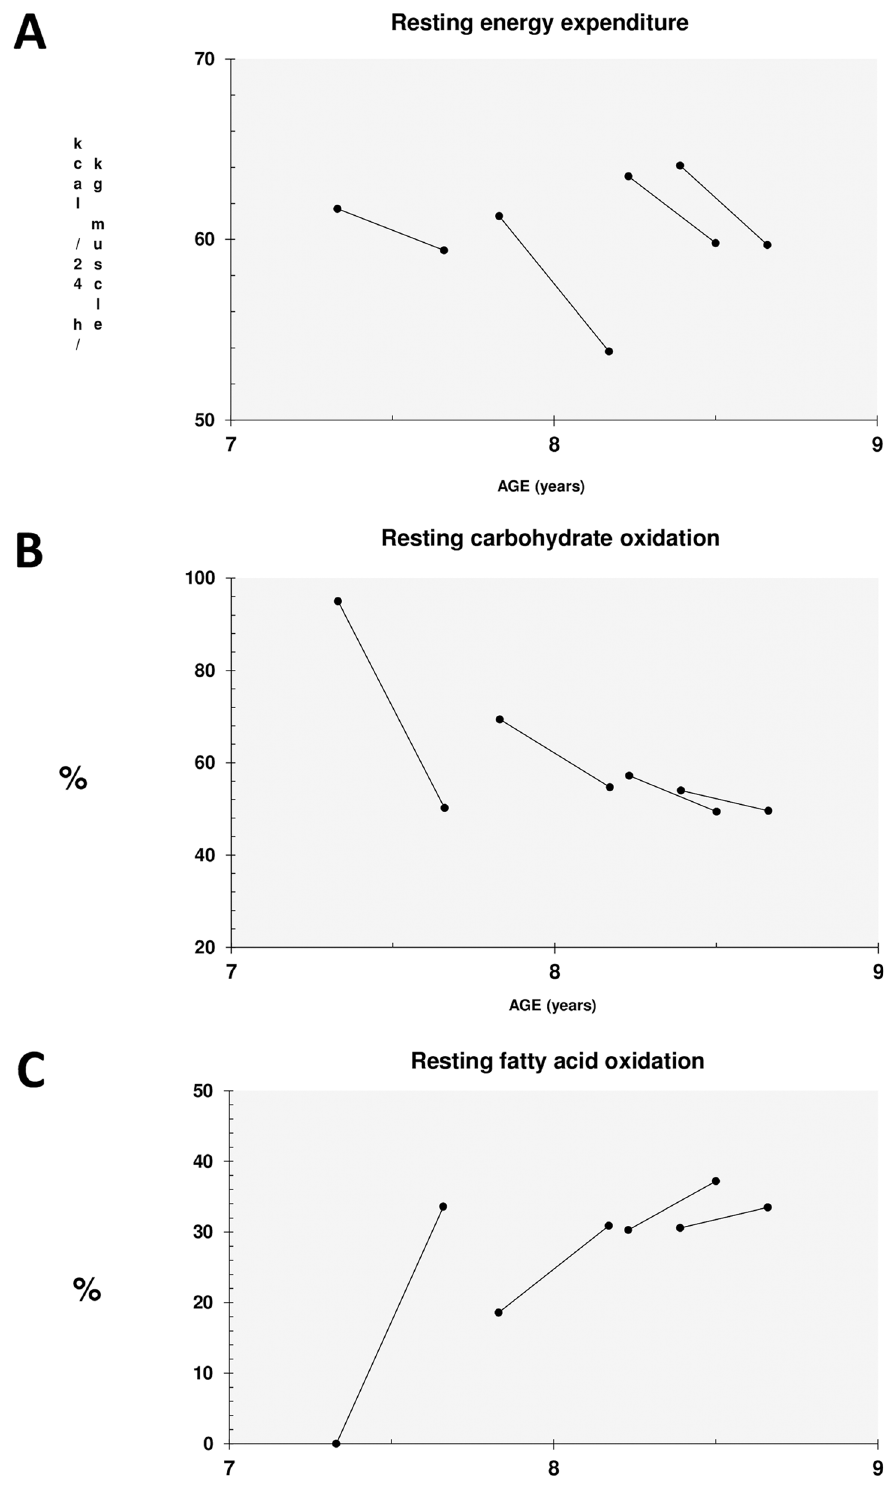
Fig 3. Indirect calorimetry. Indirect calorimetry results demonstrating consistently decreased rates of resting energy expenditure per kg muscle in 24 hours (A), reduced usage of carbohydrates as oxidative fuel (B), and increased usages of fatty acids (C) in oxidative energy metabolism.